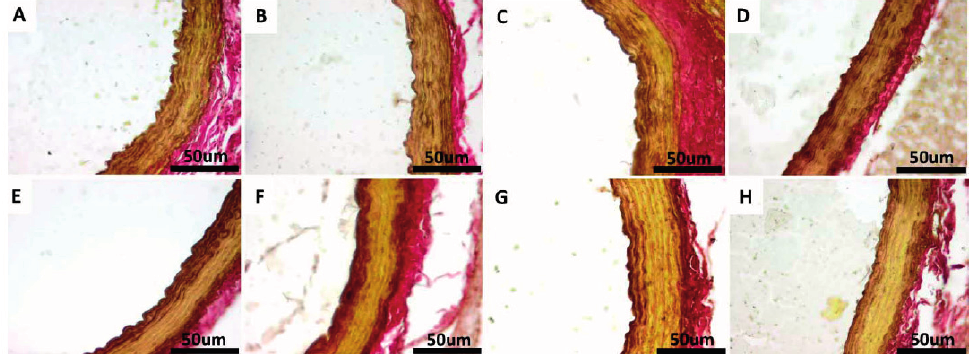
Figure 8. Transverse sections of the aorta stained with Verhoeff-Van Gienson (VVG) stain method for elastic fibers in: CS group: non-diabetic sedentary untreated control rats ( A ); CE group: non-diabetic trained untreated control rats ( B ); CSQ group: non-diabetic sedentary control rats treated with quercetin ( C ); CEQ group: non-diabetic trained control rats treated with quercetin ( D ); DS group: diabetic sedentary control rats ( E ); DE group: diabetic trained untreated control rats ( F ) and DSQ group: diabetic sedentary rats treated with quercetin ( G ); DEQ group; diabetic trained rats treated with quercetin ( H ). VVG stain, original magnification of 40×. Scale bar = 50 μ m.